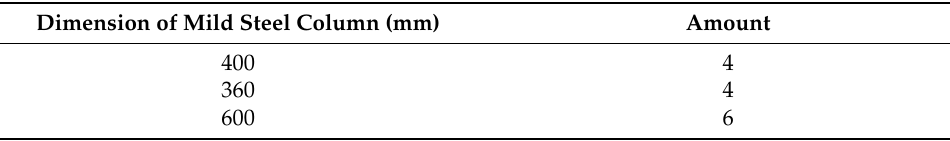
Table 9. Dimension and amount of mild steel columns